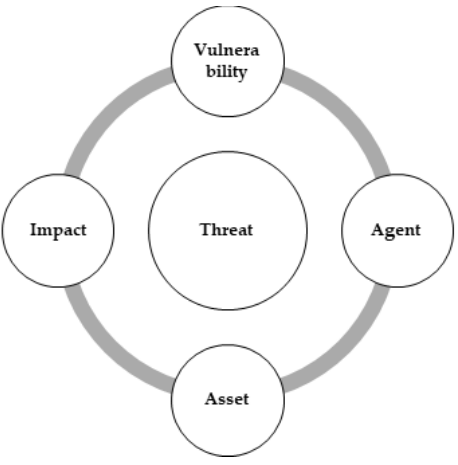
Figure 2. Proposed dimensions of a security threat.